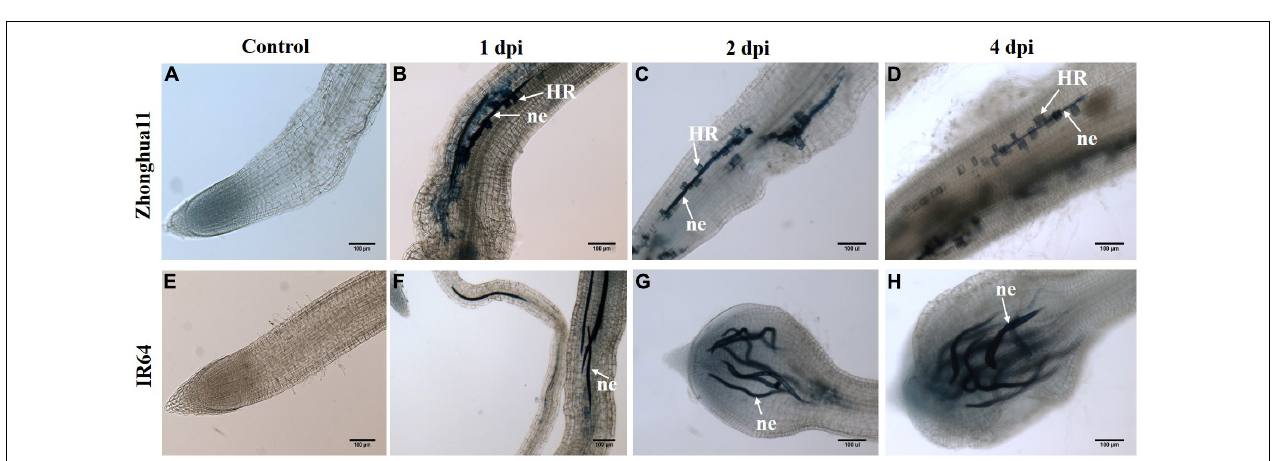
FIGURE 3 | Meloidogyne graminicola triggers plant cell death in Zhonghua 11 with dead cells paving the way along the nematode migration tracks in roots. Trypan blue staining of roots in (A–D) Zhonghua 11 and (E–H) IR64 plant before (control) and after infection with M. graminicola at 1, 2, and 4 dpi, respectively. ne, nematode; HR, hypersensitive reaction. Both the nematode juveniles and the root dead cells appear in blue colour. Scale bar: 100 µ m. observed incompatible interaction in Zh11 rice in response to M. graminicola